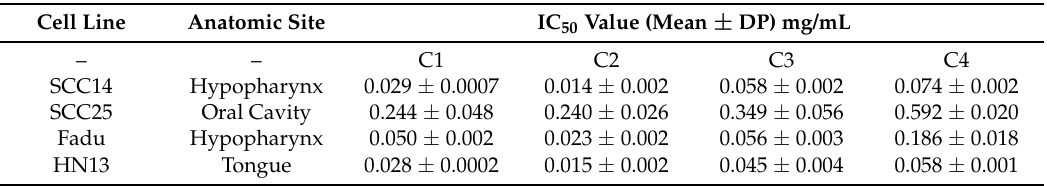
Table 2. Classification and IC 50 value response to different fractions of the T. guianensis extract in HNSCC cell lines.